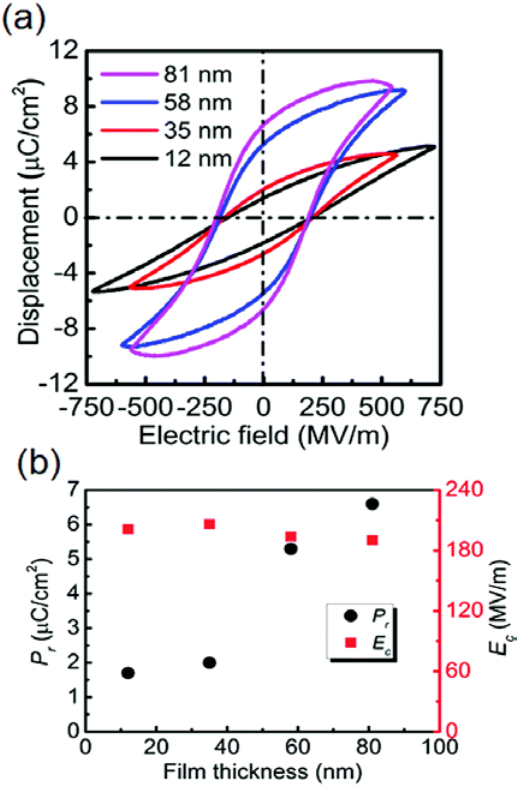
Figure 10. ( a ) The D-E Hysteresis loops and ( b ) coercive field ( E c ) and remanent polarization ( P r ) of PVDF nanofilms dependent of different film thicknesses [110].